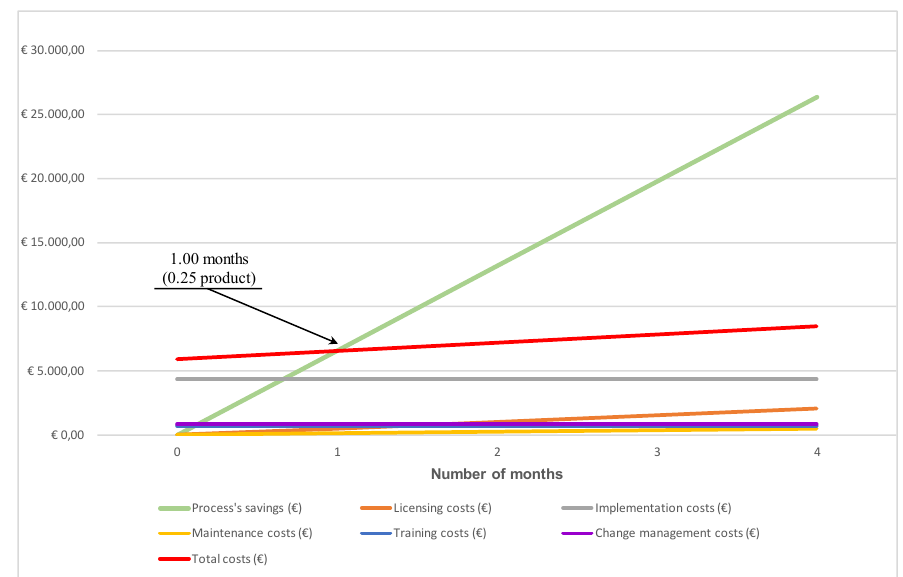
15 Table 5. Example of the rentability threshold ’ s results in a calculator table. The Cost Structure